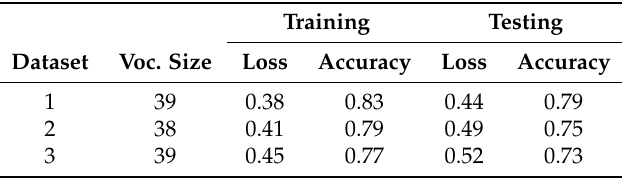
Table 8. POS-tag Sequence—One-hot Encoding Representation.